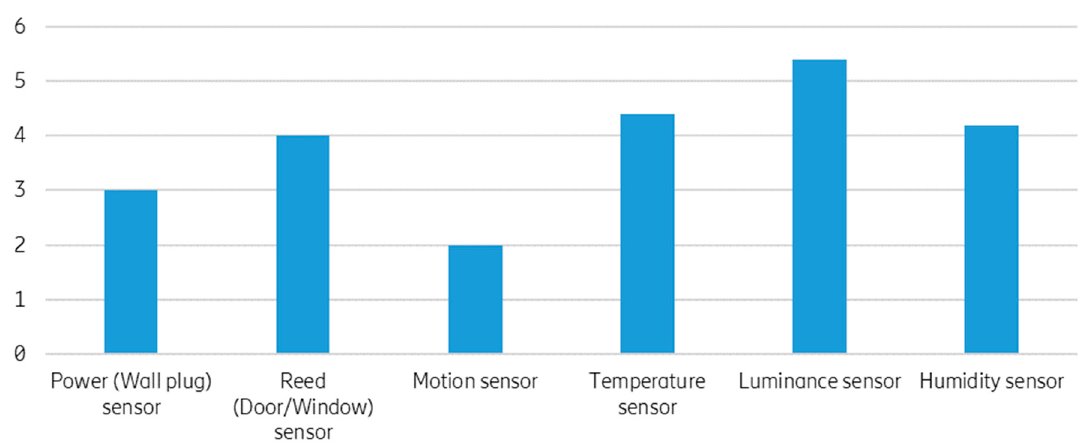
Figure 8. The average number of learned patterns per sensor.